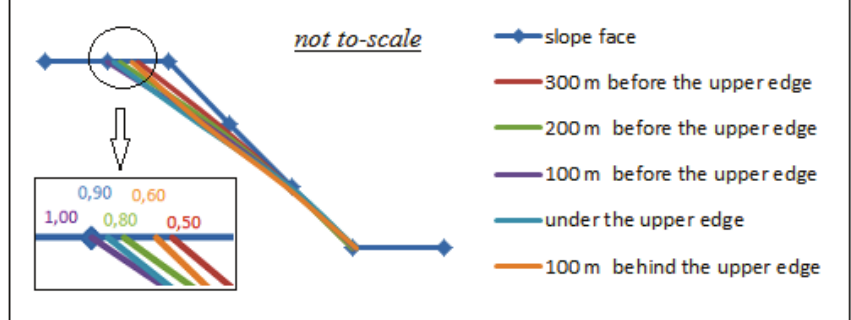
Fig. 15. Horizontal displacement of slope face when the longwall operation proceeds from the left side towards the upper edge of slope (measured point is the face of the longwall panel)